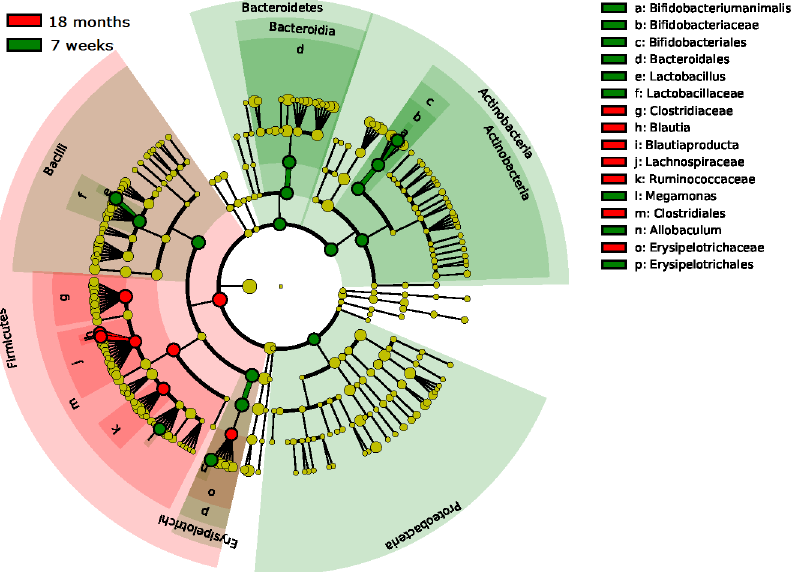
Fig 3. Linear discriminant analysis (LDA) effect size (LEfSe) showing differentially abundant bacterial taxa between 7 weeks and 15–18 months old dogs. Taxonomic groups significantly enriched in 7 weeks old puppies are indicated with green whereas the taxa enriched in 15–18 months are shown in red. P-value = 0.05 and absolute LDA score > 4.0.